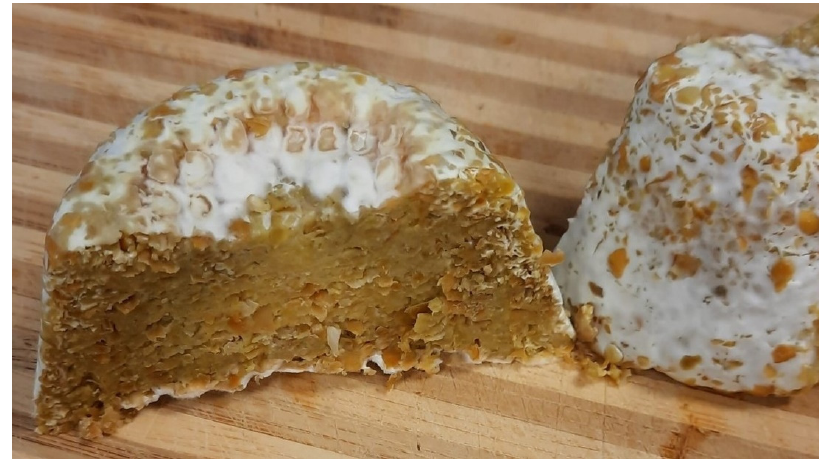
Figure 2. A representative photograph of lupine-based Camembert alternative on day 28.